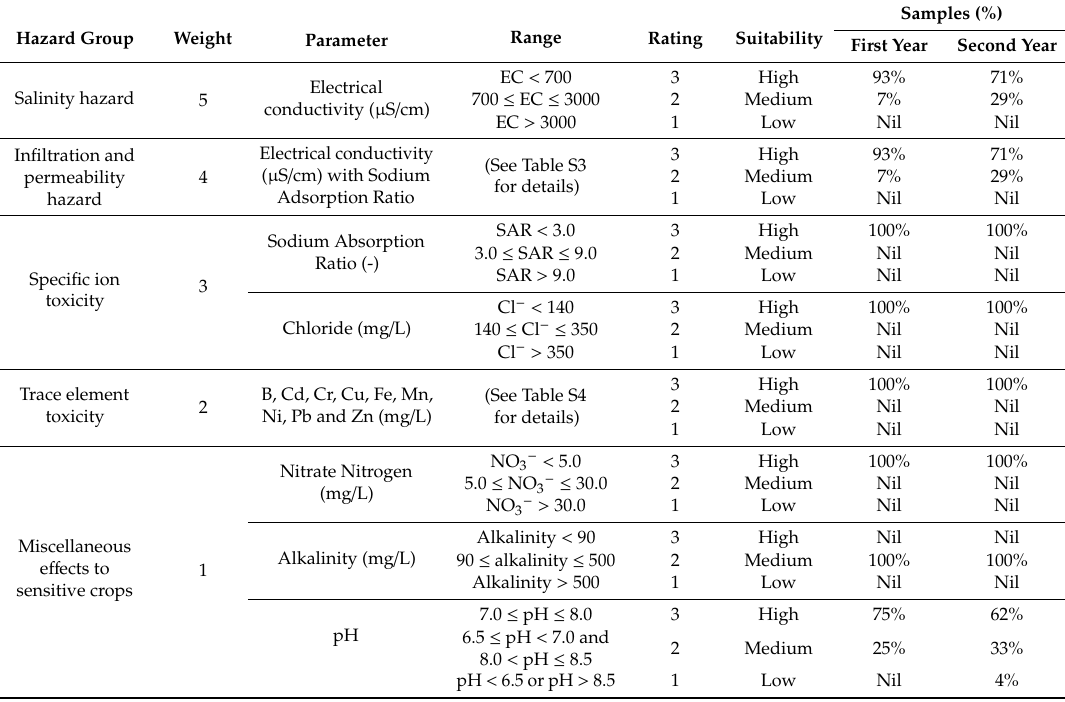
Table 3. Classification of IWQ for surface water samples.